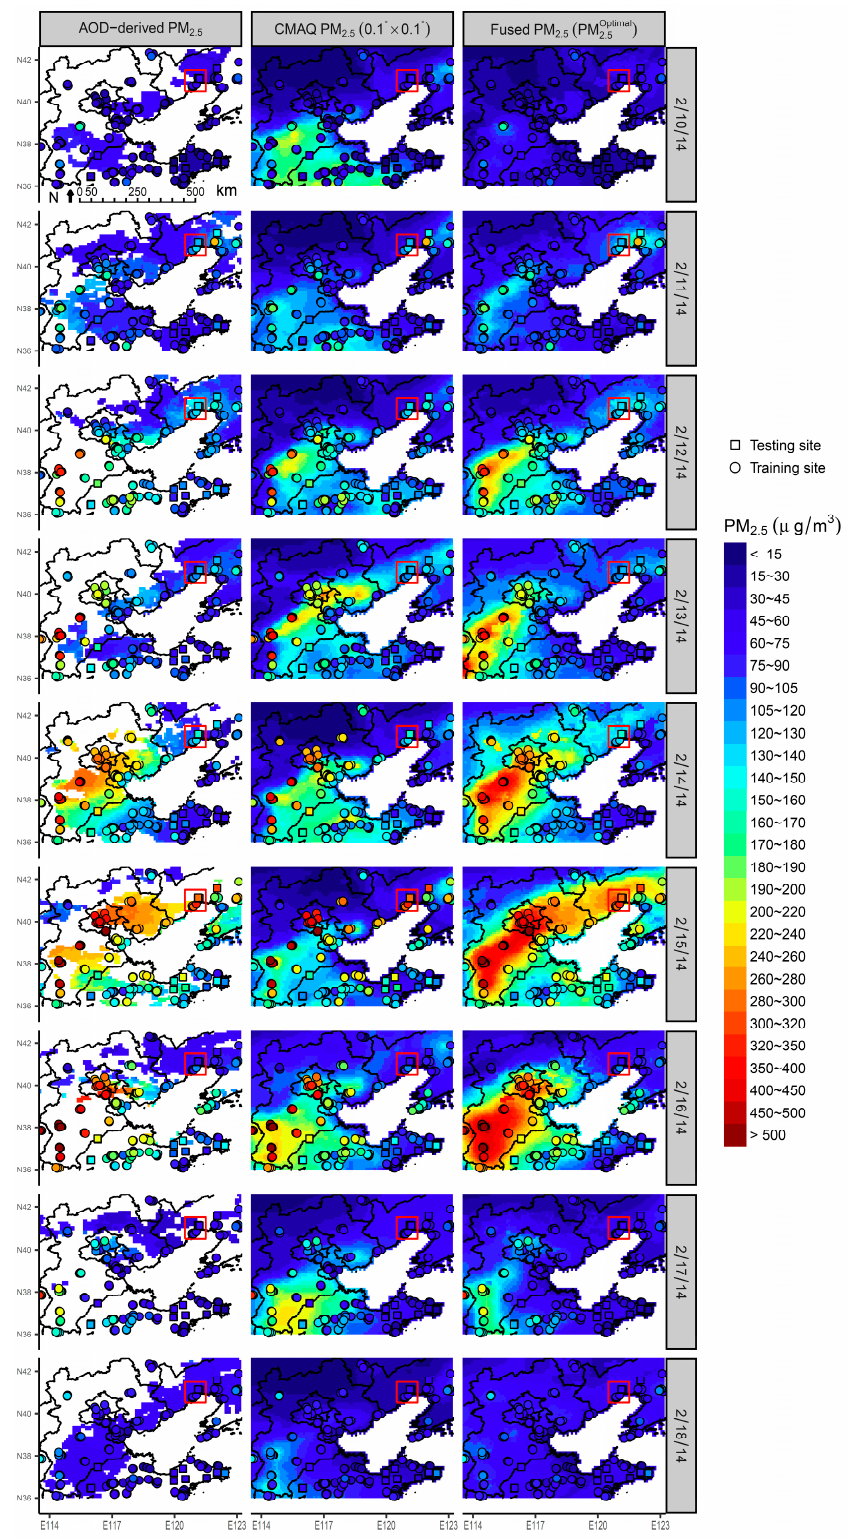
Figure 8. Spatiotemporal distributions of AOD-derived PM 2.5 , CMAQ simulations and finally fused PM 2.5 during an episode of haze around Beijing-Tianjin-Hebei region. In situ observational values are visualized by the dots. The time-series of cross-validated values for the testing site located within the red rectangle are presented in Figure 2c.